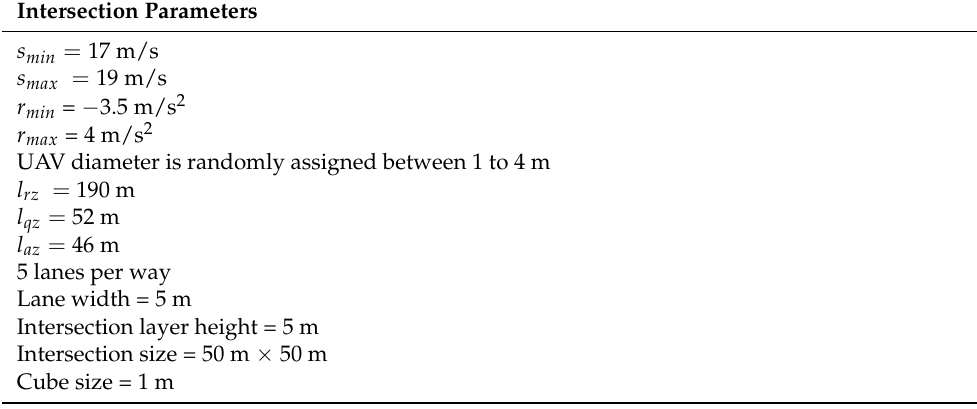
Table 2. Intersection parameters.